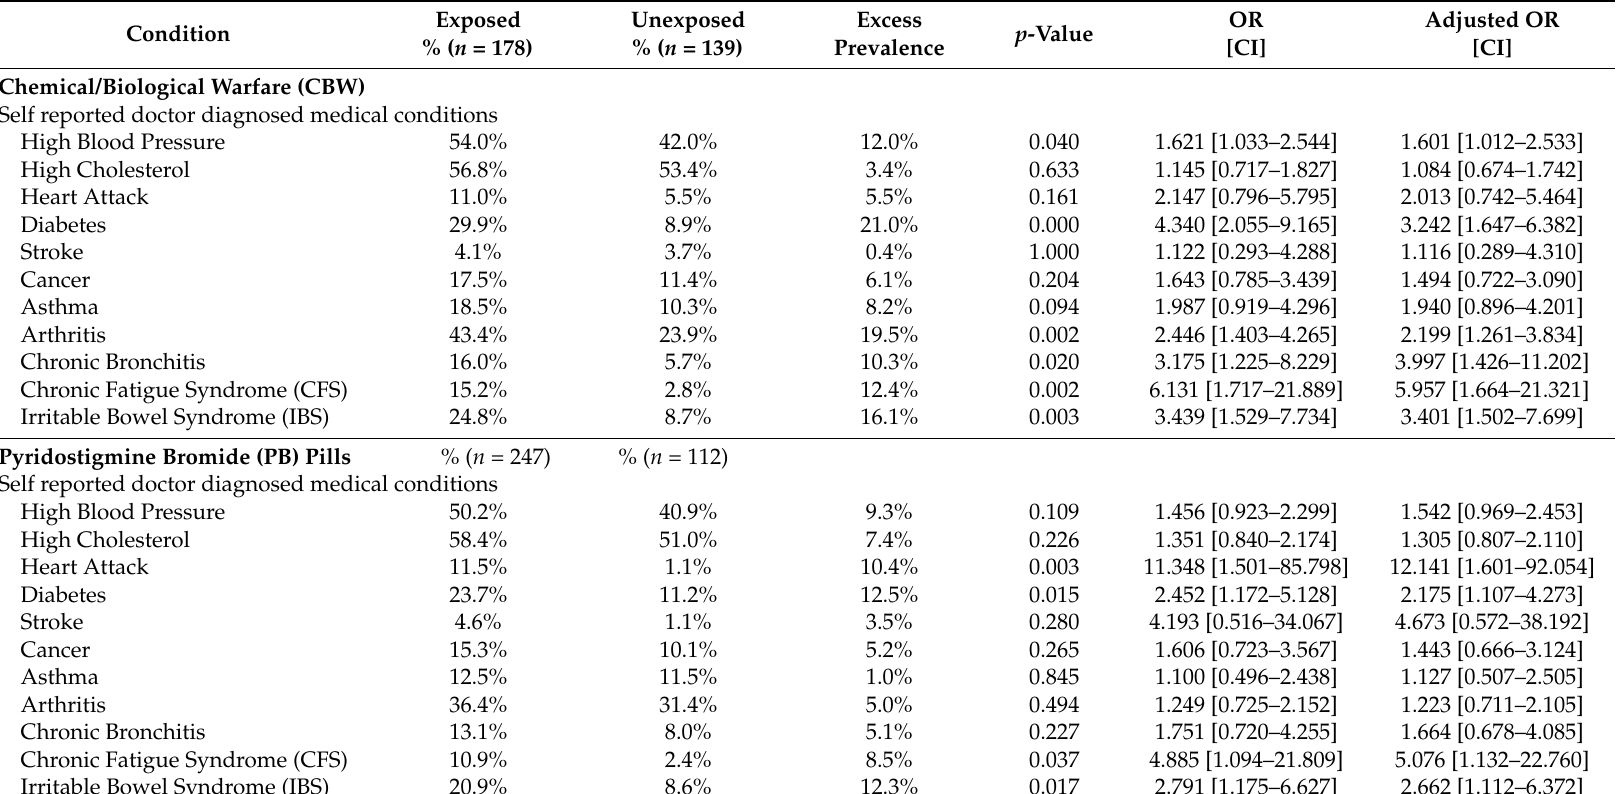
Table 4. Rates of medical conditions for exposed and unexposed Ft. Devens